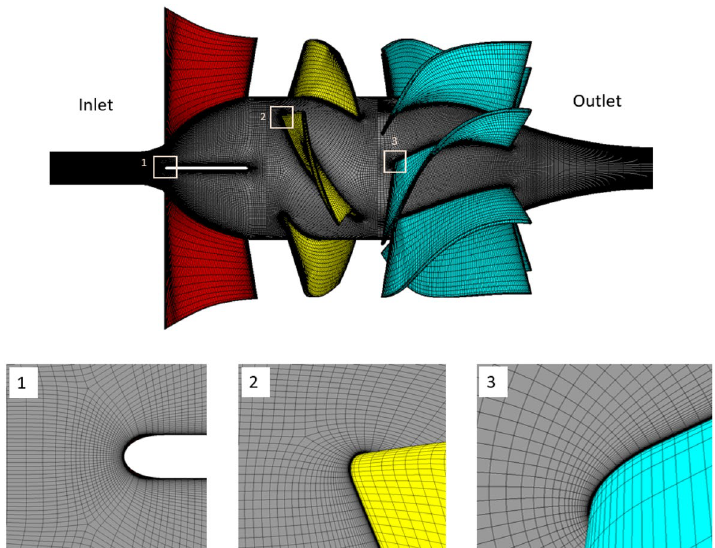
Figure 6. Grid system of the axial-flow